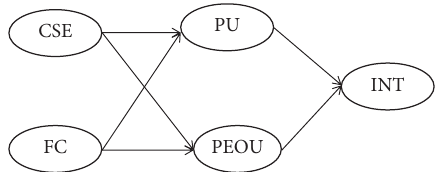
Figure 1: The conceptual framework. Note: CSE � computer self- efficacy; FC � facilitating conditions; PU � perceived usefulness; PEOU � perceived ease of use; INT � intention to use cloud e-